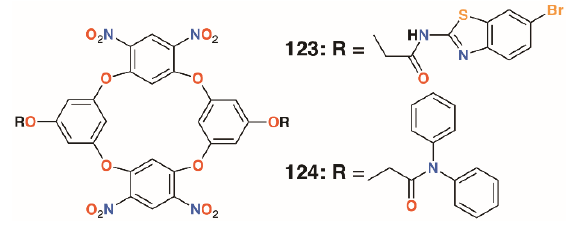
Figure 18. Jain’s oxacalixarenes.